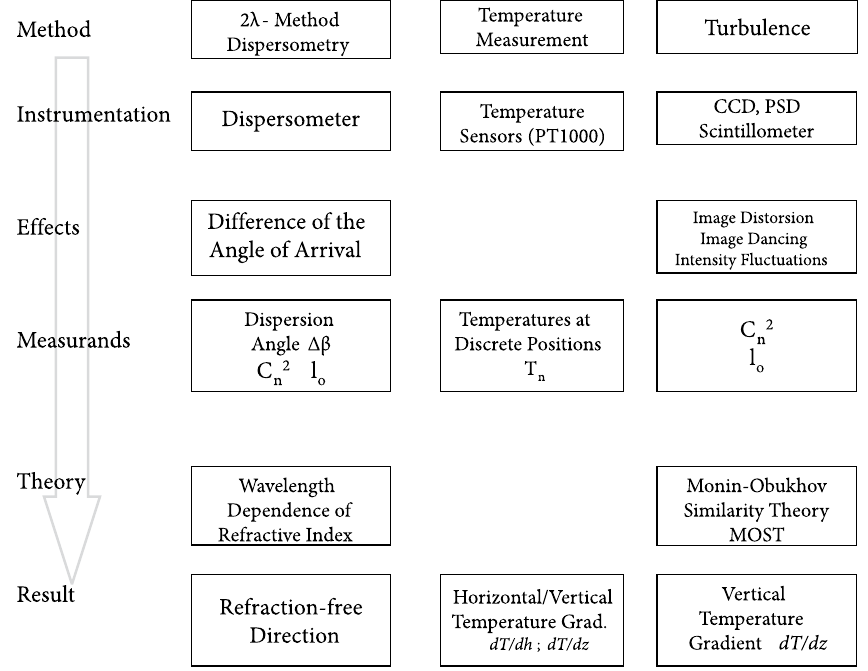
Fig. 1. Refraction determining